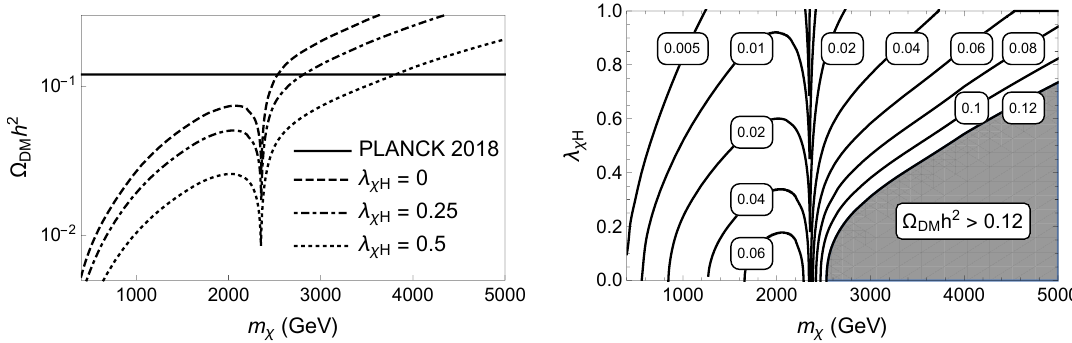
Figure 3 . (Left panel) Thermal relic abundance of the dark matter Ω DM h 2 as a function of m χ for several choices of λ χH . The horizontal line (PLANCK 2018) is the dark matter density observed today Ω (obs) h 2 ’ 0 . 120 . (Right panel) Contours of the abundance on the ( m χ , λ χH ) -plane. The DM region that the dark matter is overproduced, Ω DM h 2 & 0 . 120 , is shown as a dark-gray shaded